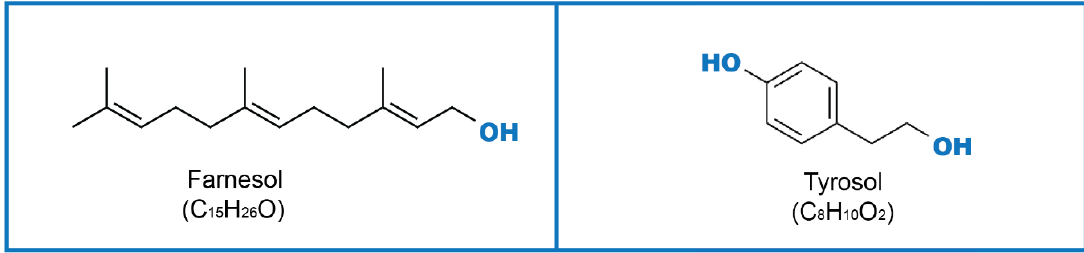
Figure 1. Farnesol (Far), Tyrosol (Tyr) molecular structures.